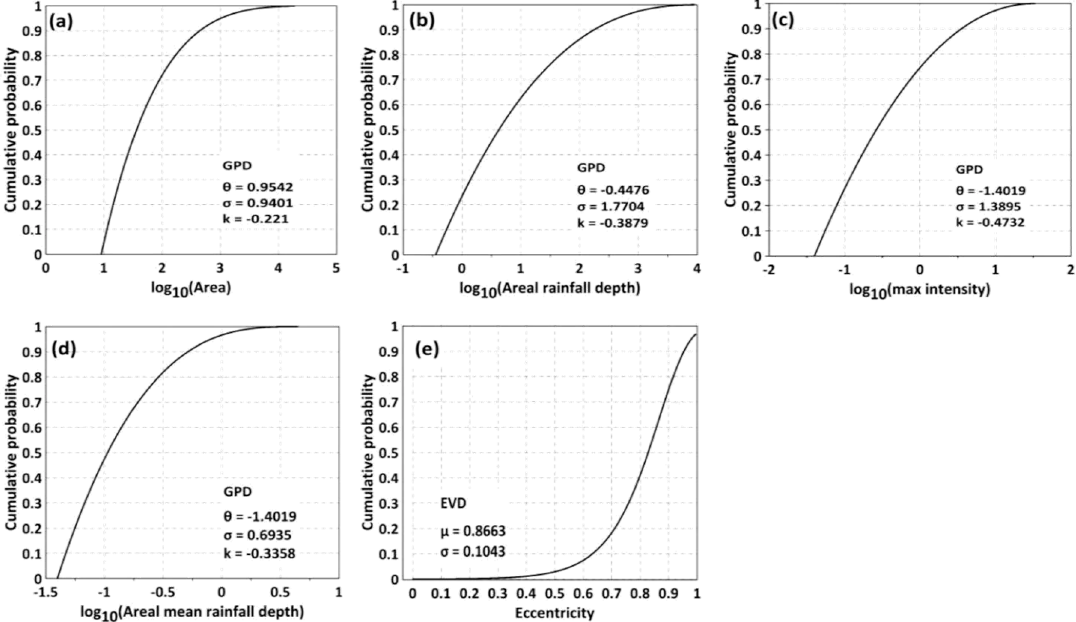
Figure 6. Cumulative curves of fitted probability density functions for log 10 -transformed rain cell properties: ( a ) area, ( b ) areal rainfall depth, ( c ) maximum intensity, ( d ) areal mean rainfall depth and property, ( e )